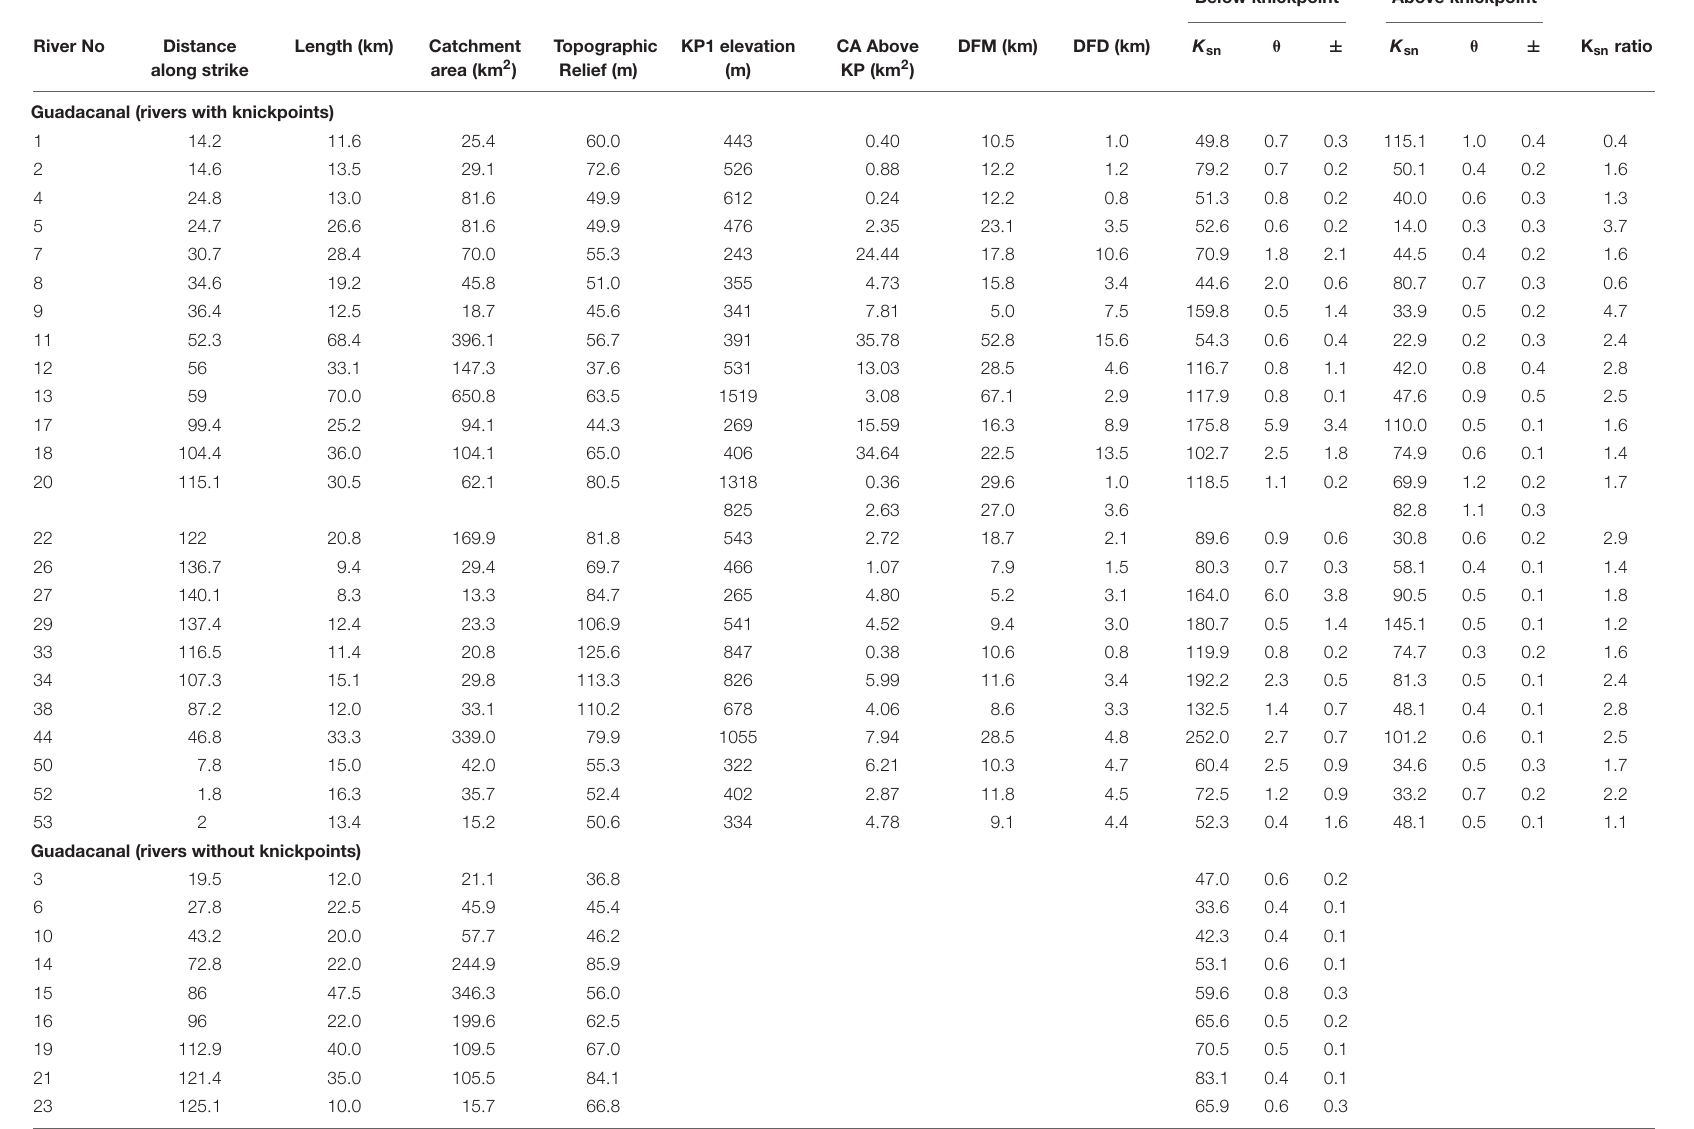
Below knickpoint Above